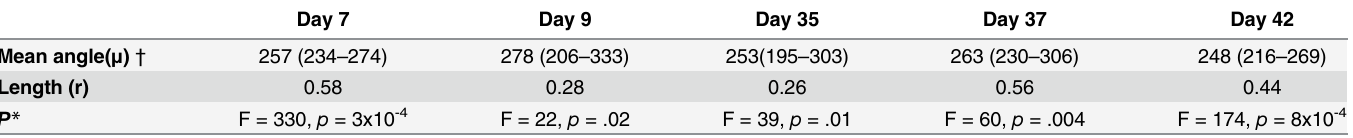
Table 1. Mean vector properties of eating behavior